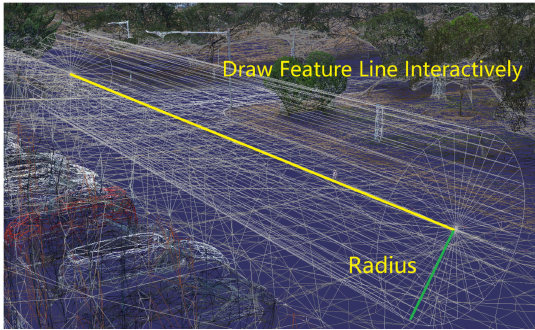
Figure 2. Schematic diagram of cylinder selection range.